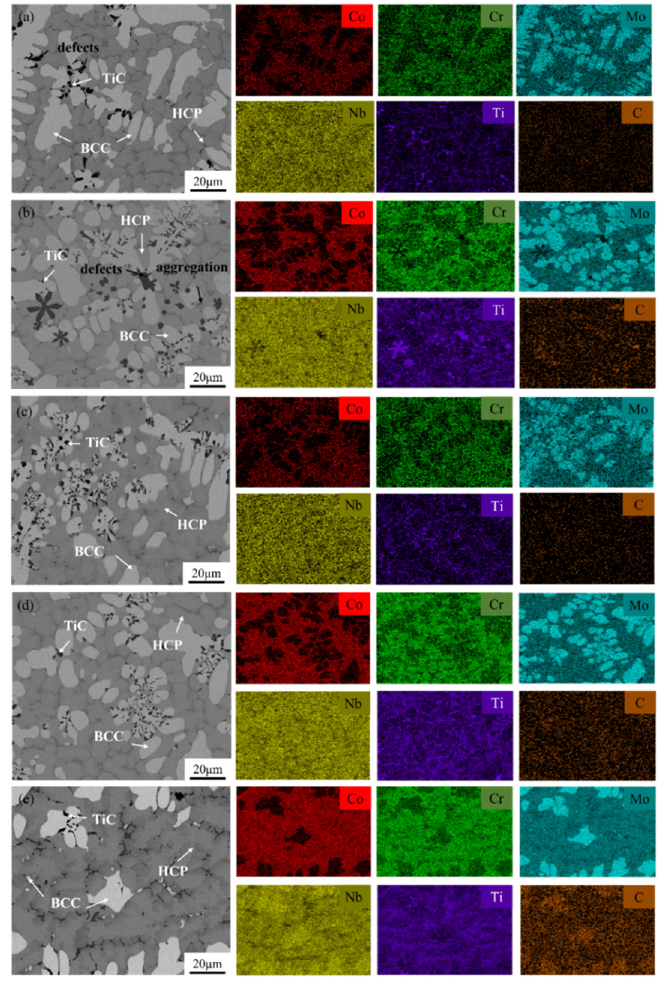
Figure 7. Characteristic microstructure of LMD-processed specimen fabricated at various pro- cessing parameters and EDS mapping showing the elemental distributions. ( a ) E l = 2.8 J/mm, ( b ) E l = 3.2 J/mm, ( c ) E l = 3.6 J/mm, ( d ) E l = 4.0 J/mm, ( e ) E l = 4.4 J/mm.